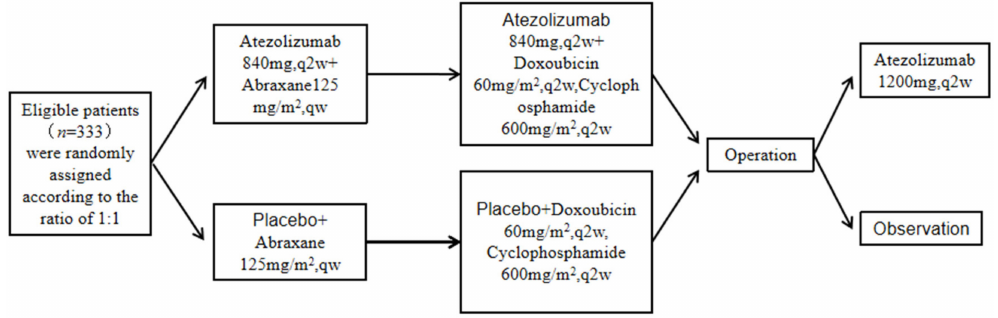
Figure 4. Experimental flow of